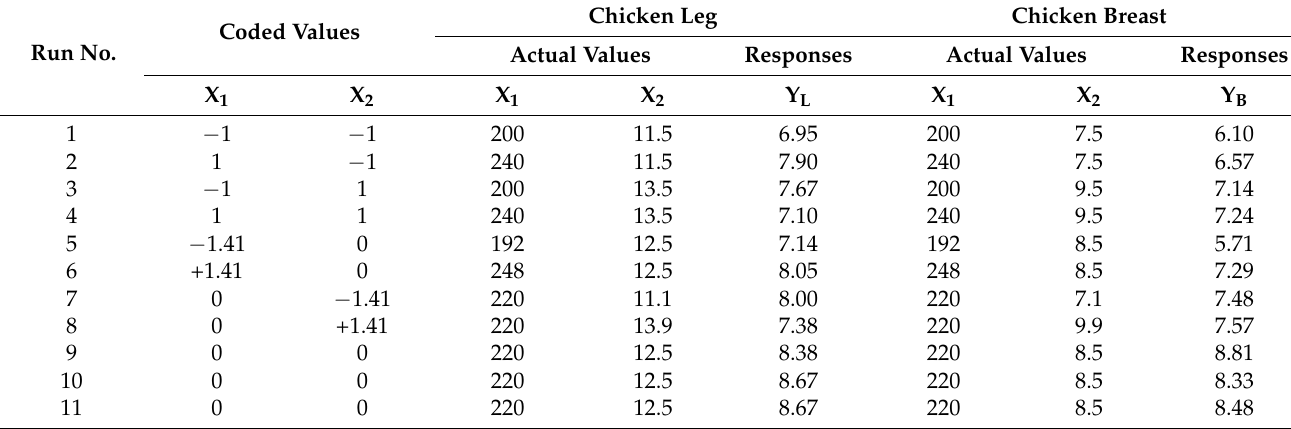
Table 2. Central composite design of independent variables and response of dependent variables during optimization of superheated treatment of chicken products: X 1 , temperature; X 2 , time; Y L , overall acceptance of chicken leg; Y B , overall acceptance of chicken breast. Chicken Leg Chicken Breast Coded Values Run No. Actual Values